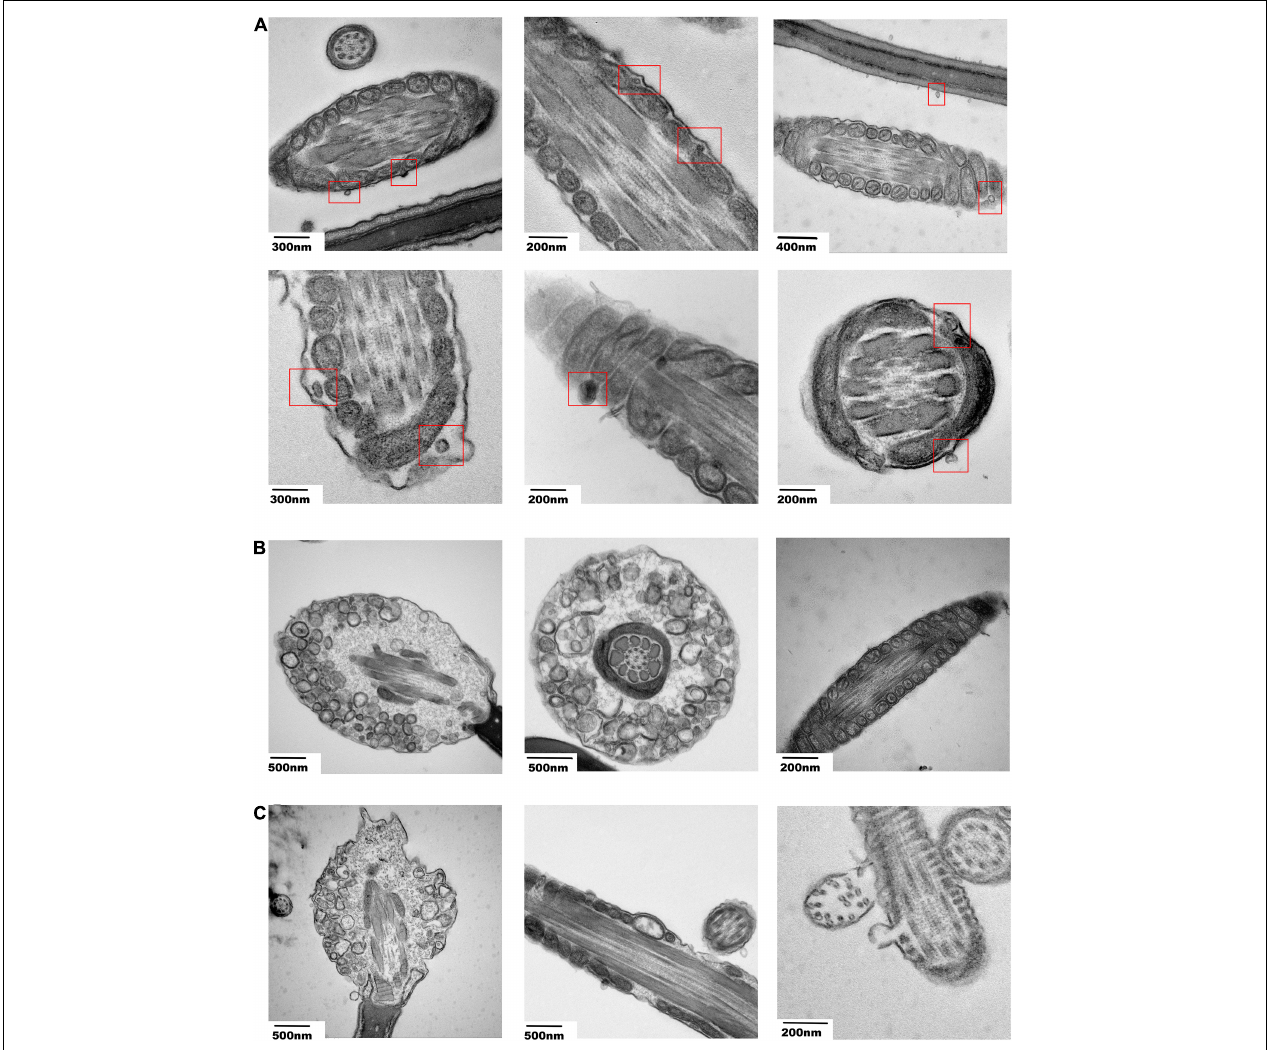
FIGURE 6 | Electron microscopy images of sperm incubated with transfected SPEVs. (A) Electron microscopy images showing the vesicle-like structures near the mitochondria within the cell membrane of the sperm tail. (B) Electron microscopy images showing the sperm and the shapes of mitochondria after incubation with the EV-miR-222 mimic. (C) Electron microscopy images showing the sperm and the shapes of mitochondria after incubation with the EV-miR-222